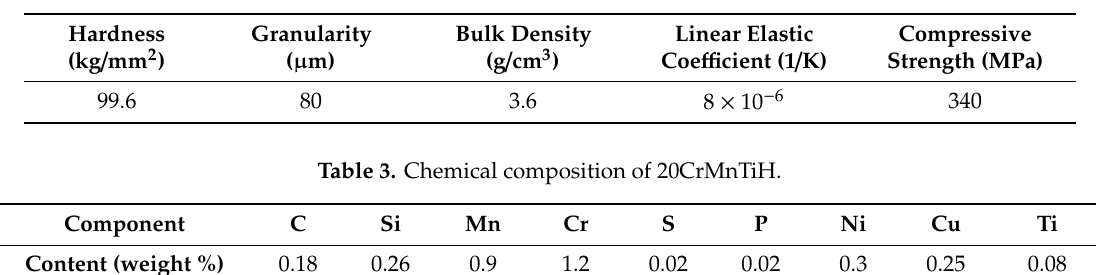
Table 2. Physical properties of microcrystalline corundum.